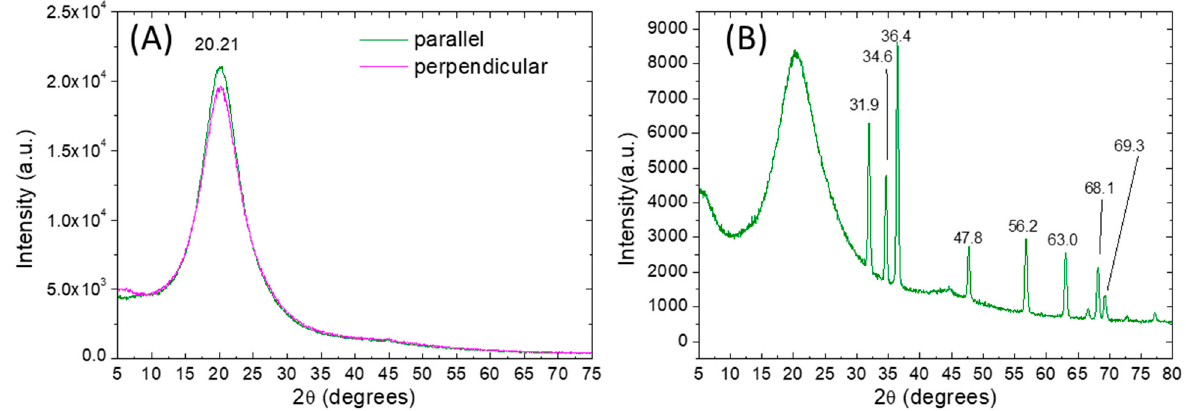
Figure 3. X-ray diffraction patterns (Cu K α ) of undoped AZO-LC-PMP ( A ) and doped AZO-LC-PMP-Z6% ( B ). For the undoped film the spectra are obtained by orienting the sample in two different ways (with the rubber direction parallel or perpendicular to the X-ray source).